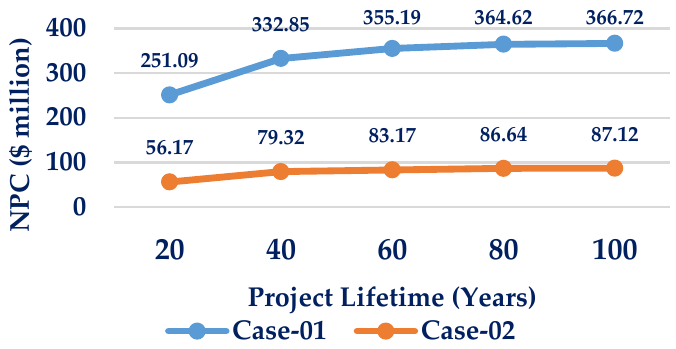
Figure 25. Impact on NPC due to variation in project lifetime.